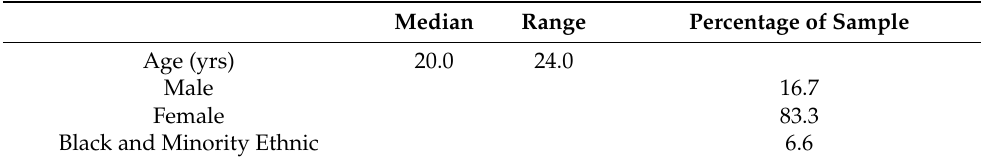
Table 1. Participants’ sociodemographic characteristics.